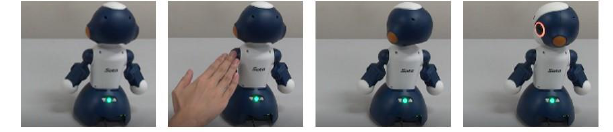
Figure 2. Video stimulus with Sota. Nao: Figure 3 shows Nao (Aldebaran Robotics), which has 25 degrees of freedom (DOFs): two DOFs for its head, six DOFs for both arms, and 11 DOFs for its lower body. It is 58 cm tall.